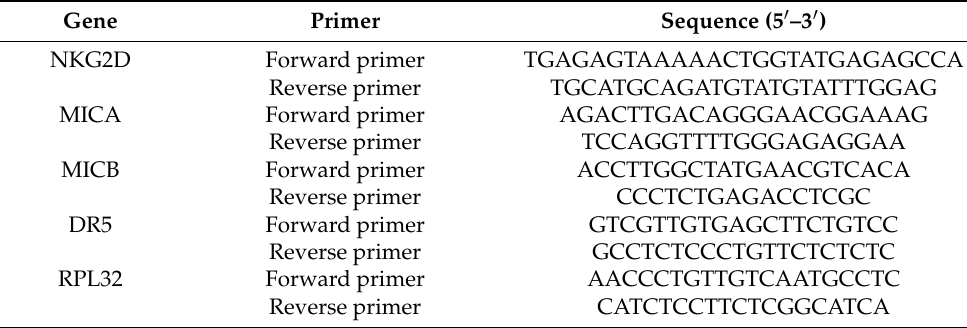
Table 1. List of PCR